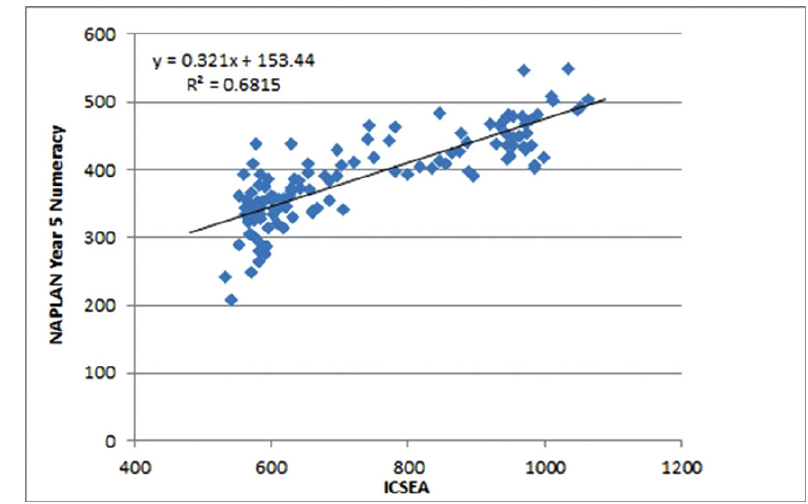
(Colour online) NAPLAN Year 5 Numeracy scores for all very remote schools by ICSEA, 2012 (n =